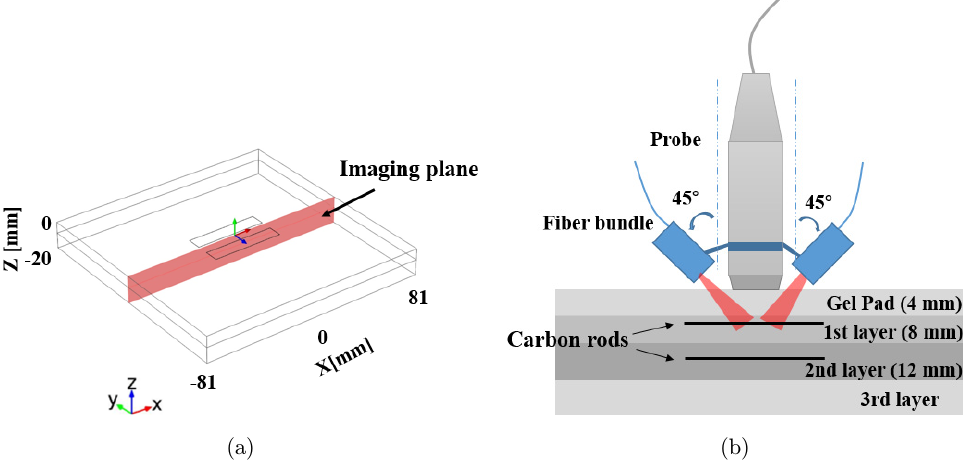
Fig. 2. (a) The shape of two layers phantom with IL added was assumed to be a cuboid in COMSOL simulation. (b) The schematic diagram of detection setup and three